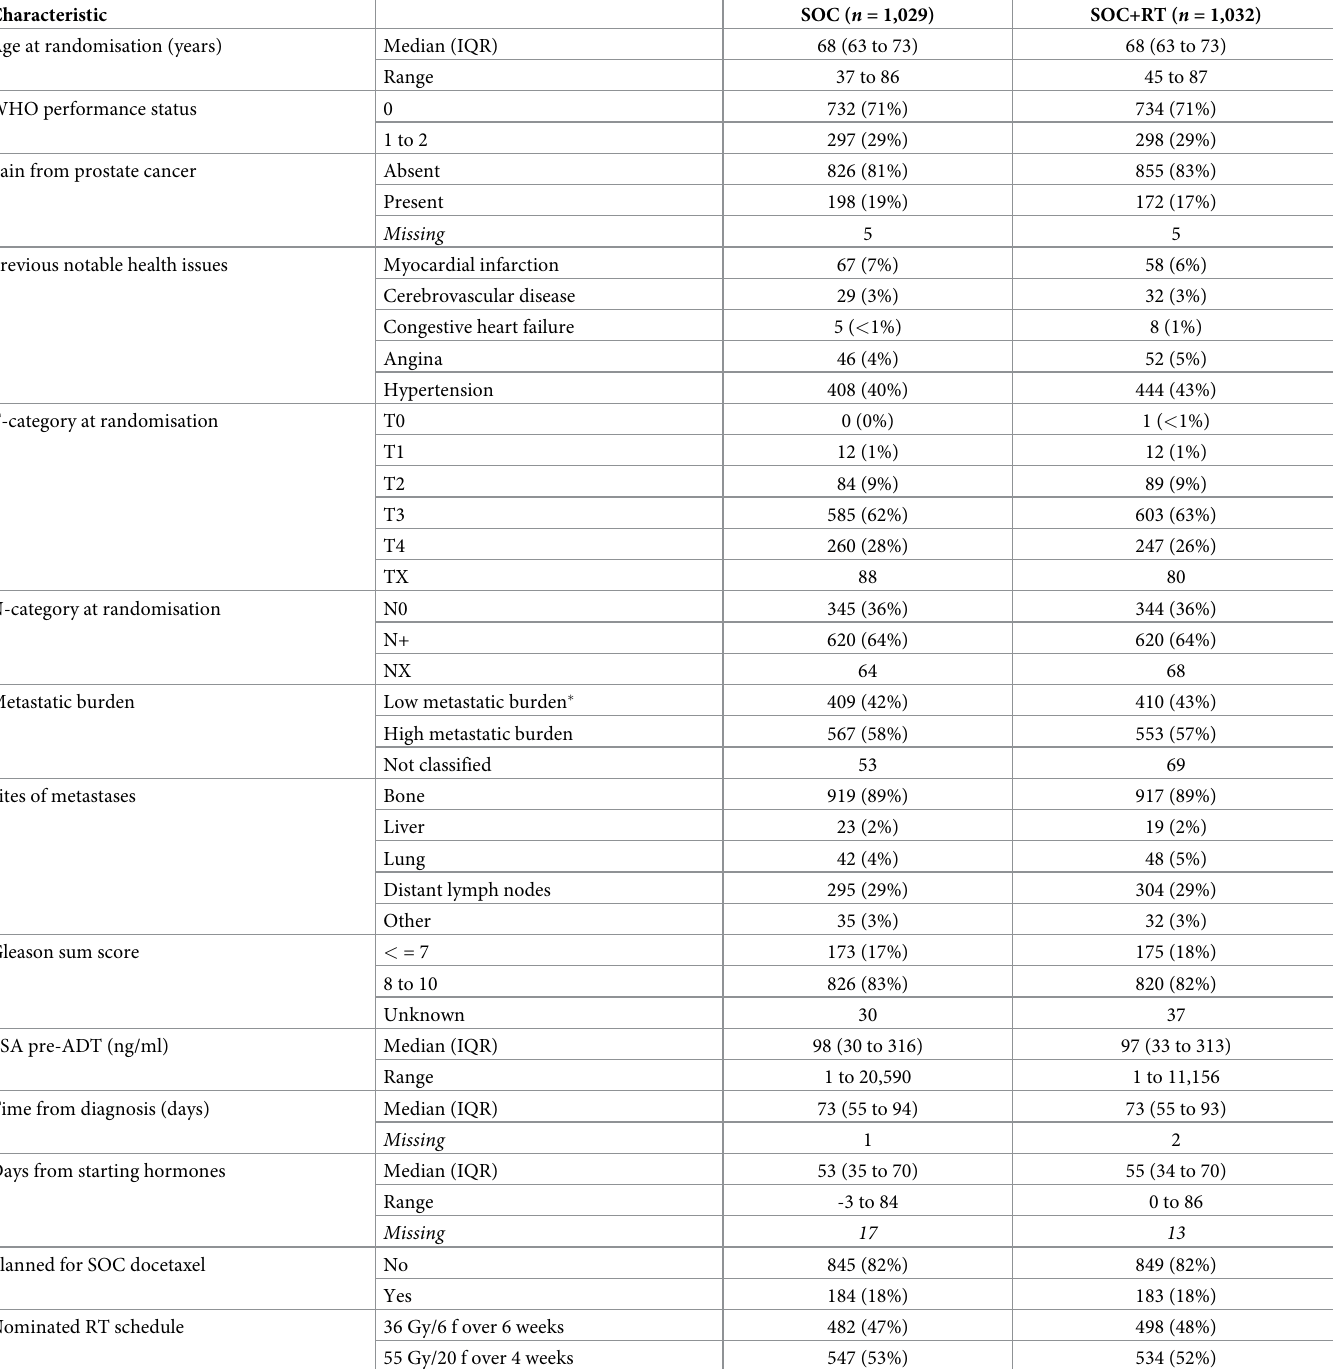
Table 1. Baseline characteristics of all patients in the